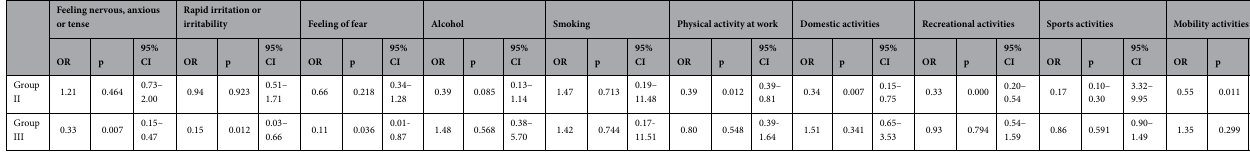
Table 9. Univariate analysis of variables (Group I as comparison group).